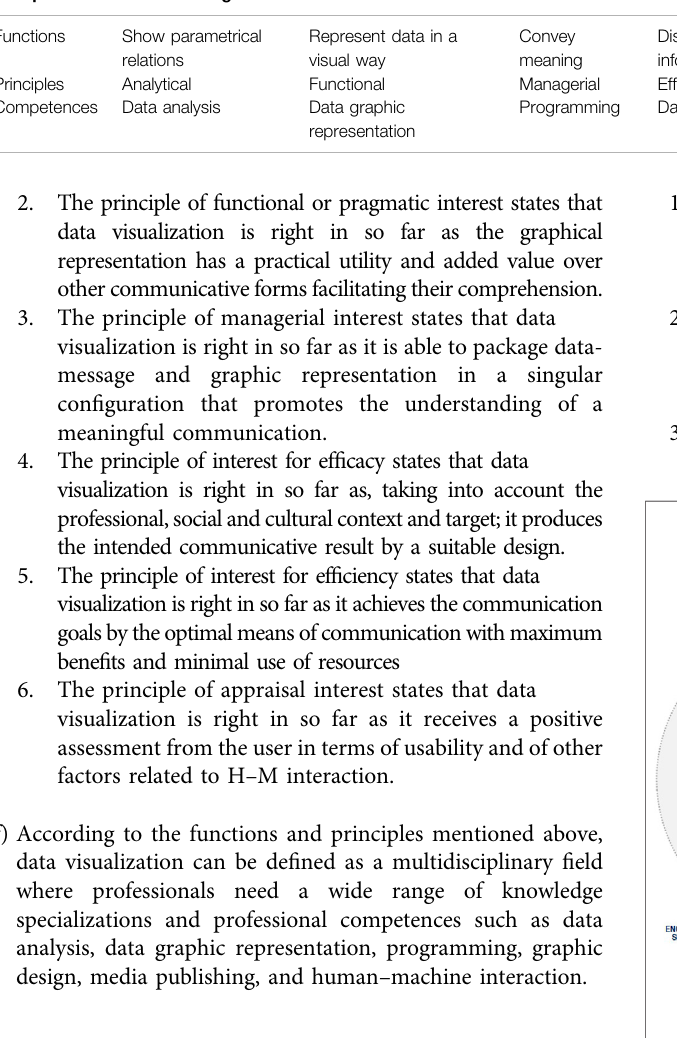
TABLE 5 | Taxonomy of data visualization: functions, principles, and competences in data visualization. Visualization element